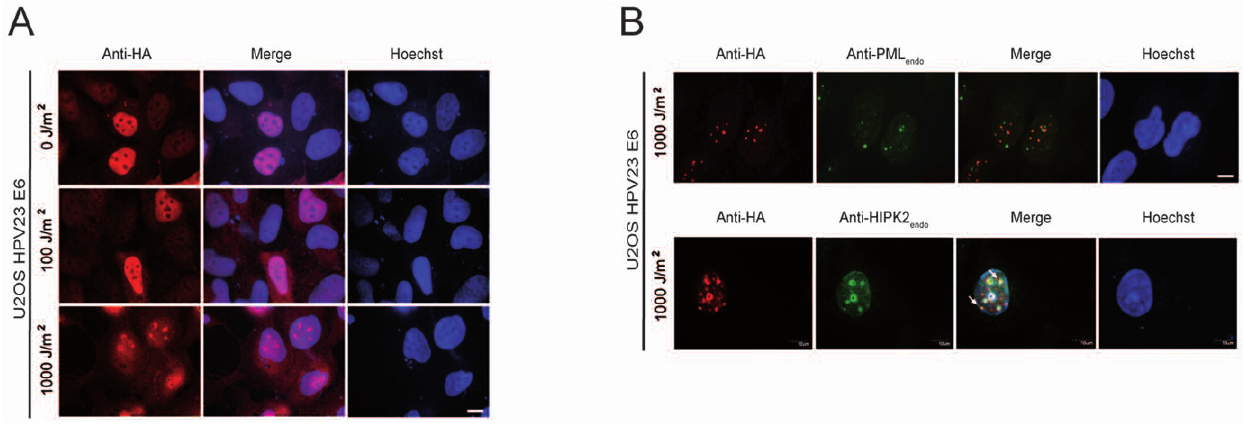
Figure 3. Lethal UVB radiation induces re-localization of HPV23 E6 proteins and co-localization with HIPK2. ( A–B ) Stably expressing HA-tagged HPV23 E6 U2OS cells were treated with sub-lethal (100 J/m 2 ) or lethal (1,000 J/m 2 ) UVB doses. Nuclear DNA (blue) was stained with Hoechst dye. Scale bars represent 10 m m. ( A ) Immunofluoresence staining and microscopy show a diffuse expression pattern of HPV23 E6 proteins in untreated or treated (100 J/m 2 UVB) cells (red). Re-localization in nuclear bodies of HPV23 E6 proteins (red) was observed after lethal UVB doses (1,000 J/m 2 ). ( B ) These nuclear bodies did mainly not co-localize with endogenous promyelocytic leukaemia nuclear bodies (PML bodies) (green, upper panels) but co-localize with endogenous activated HIPK2 protein (green) in U2OS cells after lethal UVB radiation (yellow, lower panels, white arrows).